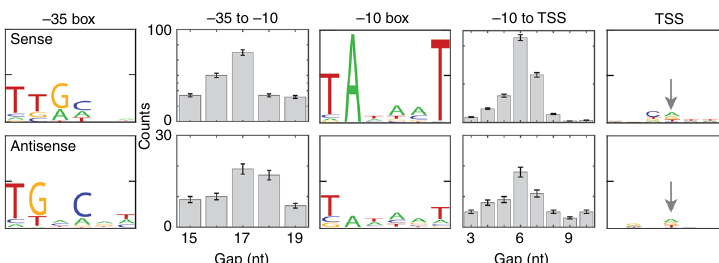
Fig. 5 Secondary initiation of antisense transcripts in vivo. a Predicted Rend-seq signature of antisense secondary initiation at an intrinsic terminator. Idealized plot shows a genomic region near a terminator (T). Termination is indicated by a peak in 3 ′ end enriched sense reads (orange). The secondary initiation hypothesis predicts nearby 5 ′ end enriched antisense reads (magenta), suggestive of antisense secondary initiation. Δ S and Δ AS are the relative amounts of sense termination and antisense initiation at particular genomic positions as estimated by the peak heights. b Peak heights from 66 (of 339 total) terminators detected in E. coli that show a substantial Δ AS peak within 500 bp of the terminator Δ S peak. Labels mark the genes shown in ( c ) and in Supplementary Fig. 6A. c Example of the phenomenon predicted in ( a ) observed in Rend-seq data from ref. 39 near the terminator of the E. coli malM gene. Shown are the factor-independent terminator RNA sequence with the peak of sense termination at the underlined red nucleotide, and the promoter-like non-template strand DNA sequence with the peak of antisense initiation at the underlined gray nucleotide. Arrows mark the positions of the displayed sequences in the Rend-seq data. d Antisense initiation peak frequency correlates with positions of sense terminators in the E. coli genome. Pooled data from 339 terminators between genes transcribed in the same direction (see Methods ). Plot shows the fraction (±s.e.m.) of 200 nt-wide windows centered at the indicated distance upstream or downstream from the terminators that exhibit a peak of antisense initiation with z -score > 12 (black). Also shown is the mean ± s.d. of negative controls (gray) in which the same analysis was repeated 100 times each using 339 randomly selected locations in the E. coli genome that lack apparent terminators. These locations were restricted to those >700 nt from an annotated terminator and were on the sense strand of genomic regions containing at least three consecutive genes in the same orientation. In 100% of these 100 control replicates, the fraction at the terminator location with a 5 ′ end AS peak was <3.9%, indicating that the difference between experimental data and controls was signi fi cant ( p < 0.01). In this analysis, we used a smaller window size than in ( b ) to improve spatial resolution and a very stringent peak height criterion, z > 12. This leads to detection of only the strongest peaks and shows that these strong antisense peaks are preferentially found in a region ± 200 nt from sense terminators. e Sequence characteristics (illustrated as in ref. 62 ) for n = 250 strong sense promoters (top) and for the n = 66 terminator-proximal antisense initiation sites shown in ( b ) (bottom), all detected by Rend-seq 39 . Logos show the sequence motifs for the − 35 box, − 10 box, and transcription start site (TSS, arrow); histograms display the distributions of spacings between these elements. When the size of the − 10 box was expanded from six to 8, 9, or 10 bp, there was no strong evidence for extended − 10